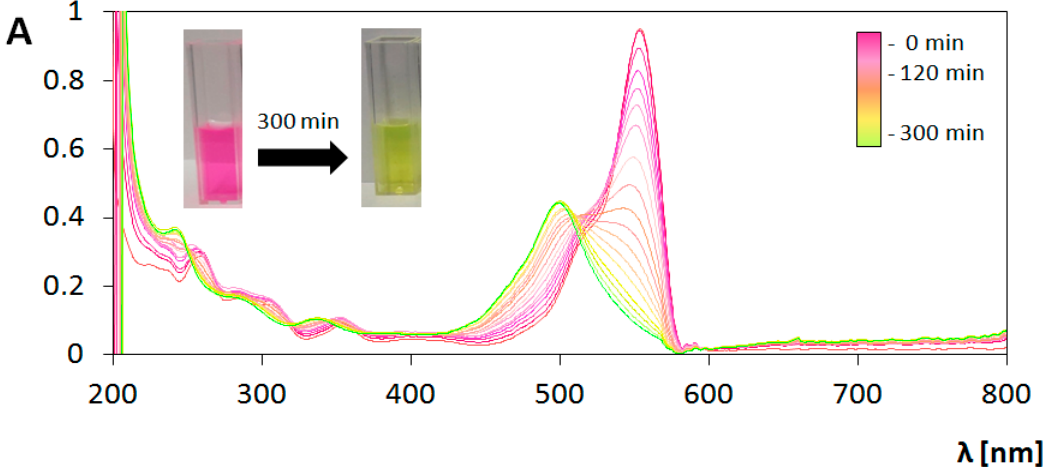
Figure 9. Changes in absorption spectrum of RhB solution during photocatalysis on bare TiO 2 coating under visible light (Vis) irradiation. Insert: change in color of solution.